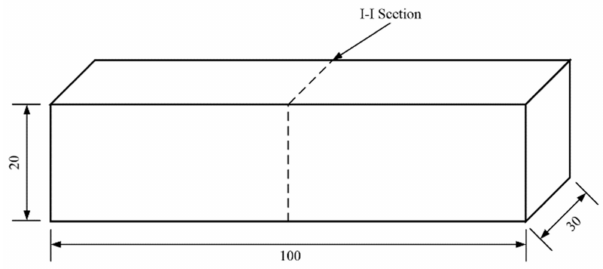
Figure 1. Beam model (cm).